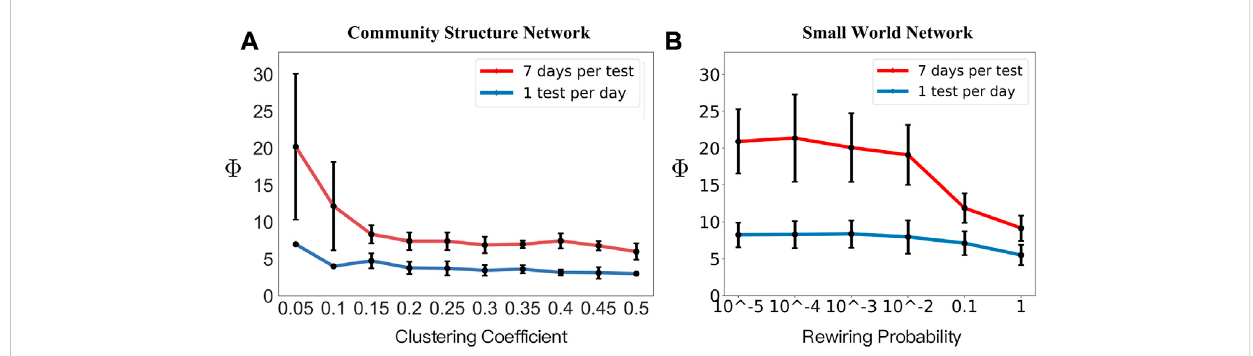
FIGURE 6 Hidden spreading period span Φ results. Holding a control measure of c = 0.03, two testing frequencies are chosen, a test per day (blue lines) and a testper7 days(redlines). (A) Asetofcommunitystructurenetworkshasdifferentclusteringcoef fi cients. (B) Small-worldnetworkwithsixsetsofrewiring probability were chosen, providing the average shortest path from 20.49, 11.58, 5.58, 3.43, 2.72, and 2.25, respectively.